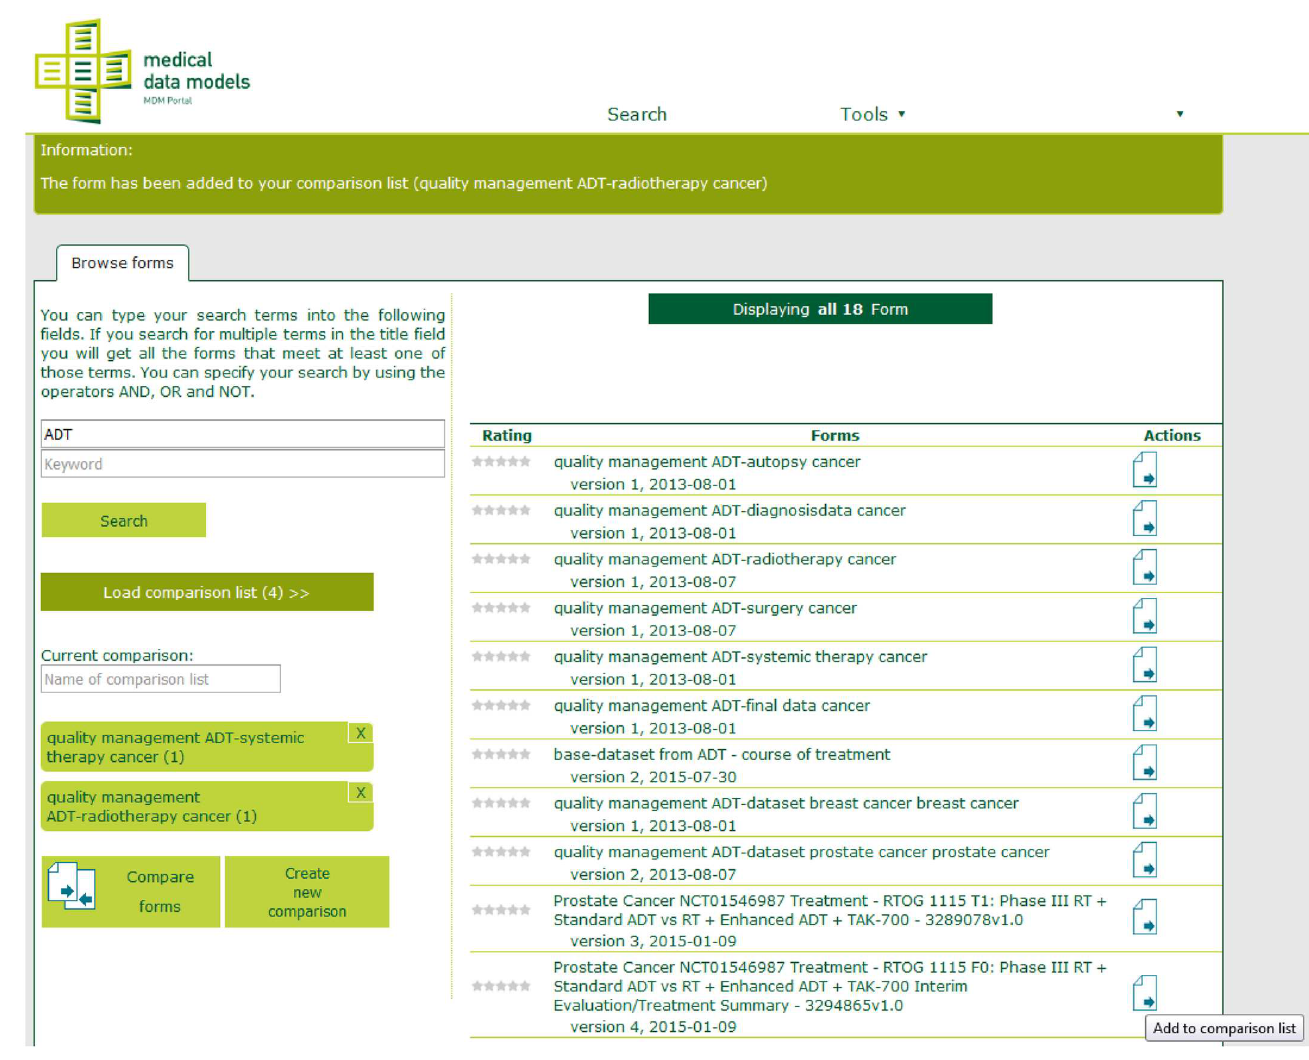
Fig 4. Screenshot from the Medical Data Model (MDM) Portal with embedded ODMSummary functionality. A form comparison list is presented on the left side. Forms can be added easily to this comparison list (Actions buttons on the right